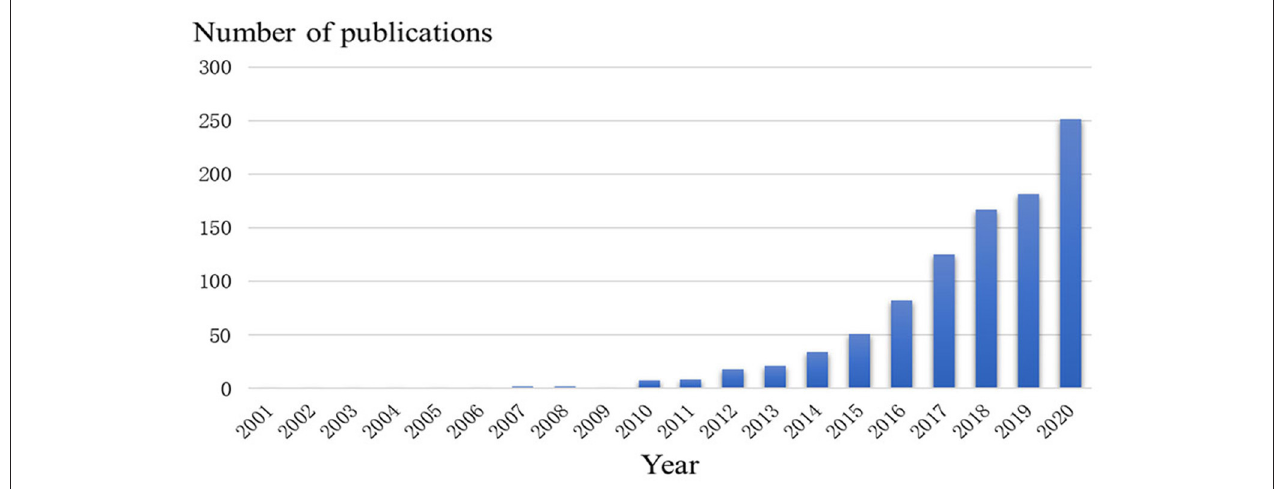
FIGURE 2 | Trends of exosomes published in cardiovascular studies over the past 20 years.